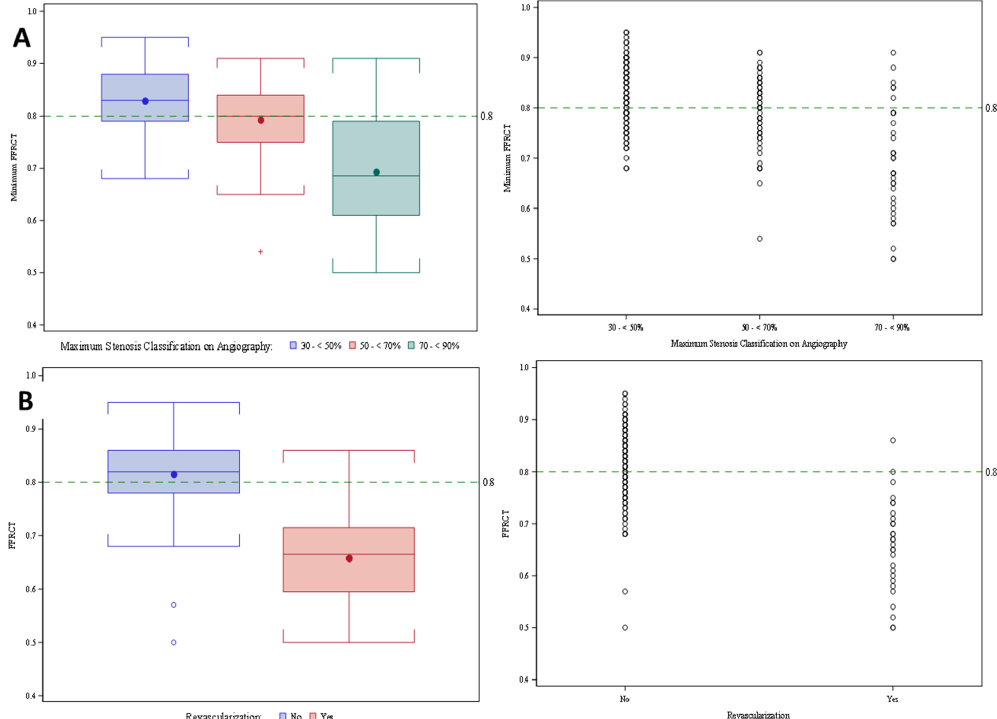
Figure 2. Distribution of diameter stenosis, fractional flow reserve from coronary computed tomography angiography (FFR CT ) and revascularization. ( A ) Boxplots and scatterplots of FFR CT value by stenosis category. ( B ) Boxplots and scatterplots of FFR CT value by revascularization.